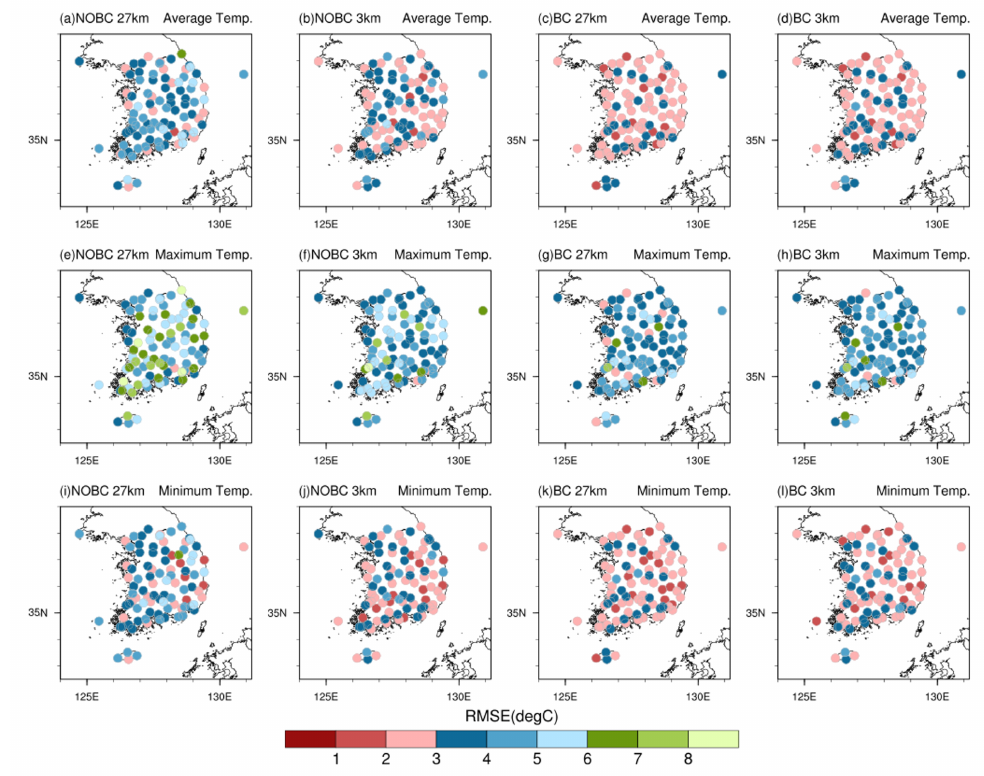
Figure 11. Same as Figure 10, except with WRF initialized at 1800 UTC on 17 July (CASE 2).